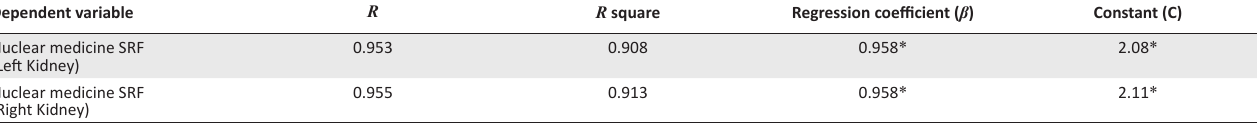
Table 4: Projection of nuclear renography (DTPA) split renal function (SRF) using radiological split renal function